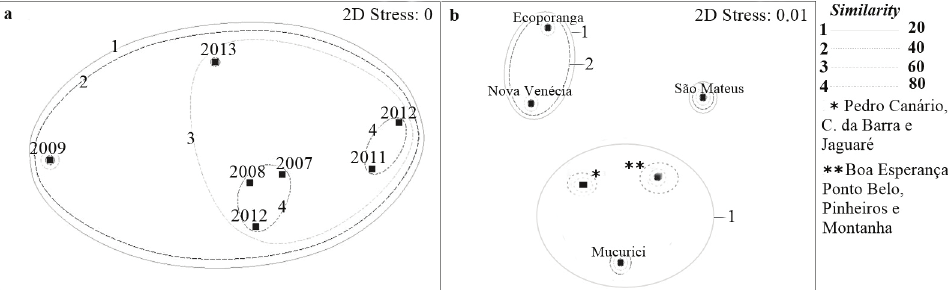
Figure 2 - Non Metric Multidimensional Scaling (MDS) – a ) Similarity of the numbers of reported cases and cities in the Northern Region - ES as the profile of notifications in the years 2007 to 2013. b ) Similarity of the cities in the Northern Region - ES as the profile of notifications in 2007 to 2013.